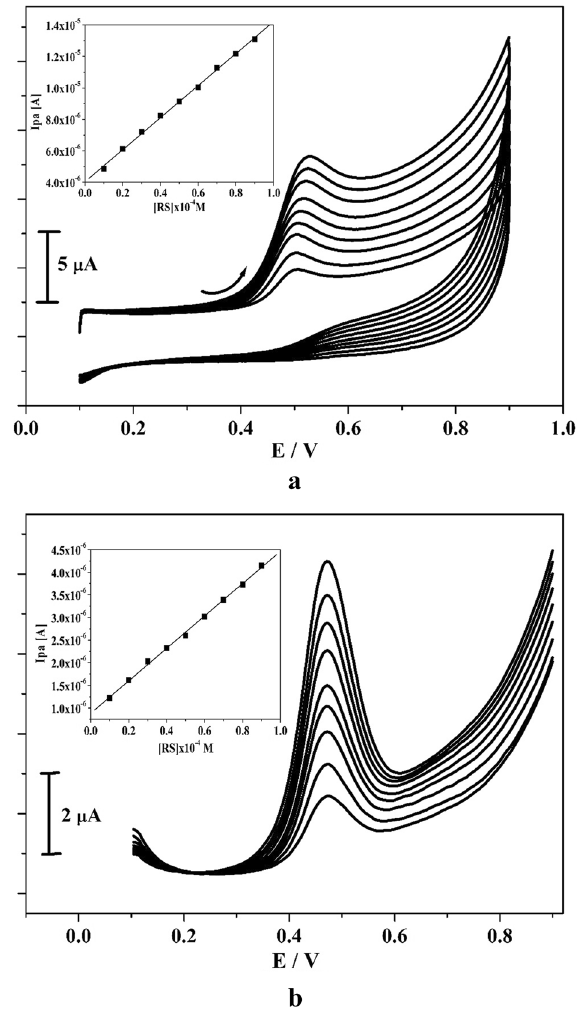
Figure 10. ( a ) CVs for various concentration of RS (10–90 µM) at poly(CBBG)/MCPE with using 0.2 M PBS (pH 7.4) with scan rate of 50 mVs -1 and inset figure is plot of Ipa versus CC concentration. ( b ) DPVs curve for changed concentration of RS (10–90 µM) at poly(CBBG)/MCPE and inset figure is plot of Ipa and concentration of